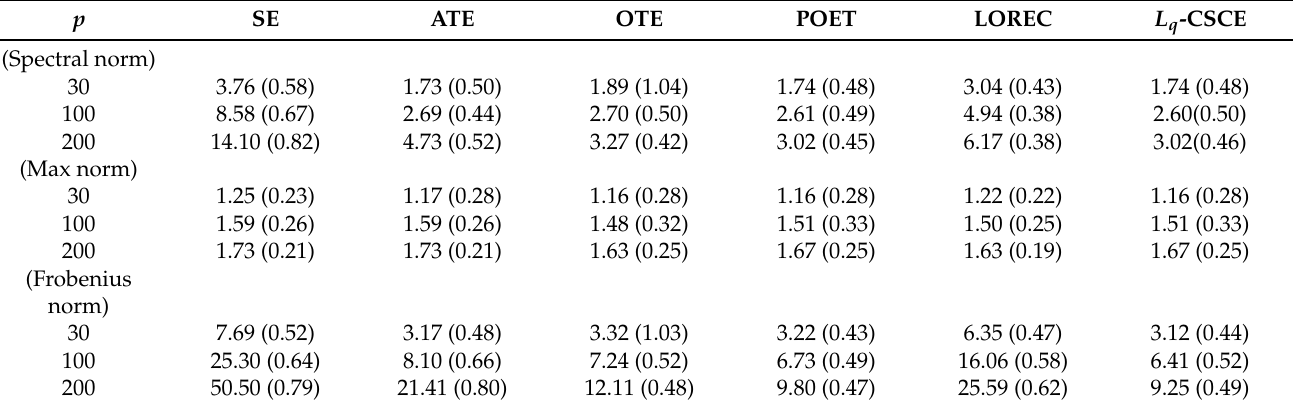
Table 1. Simulation results for Model 1 over 100 replications. The standard errors are given in